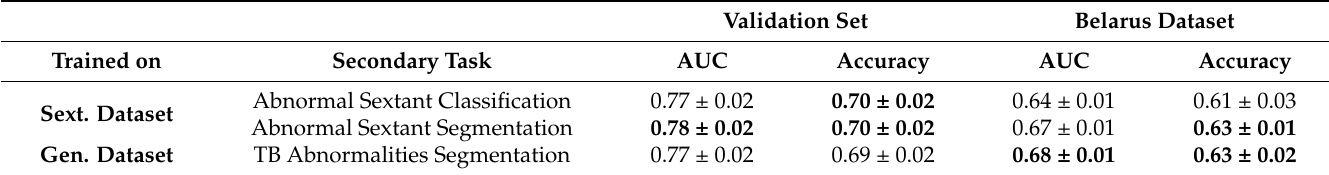
Table 8. Classification performance with an additional